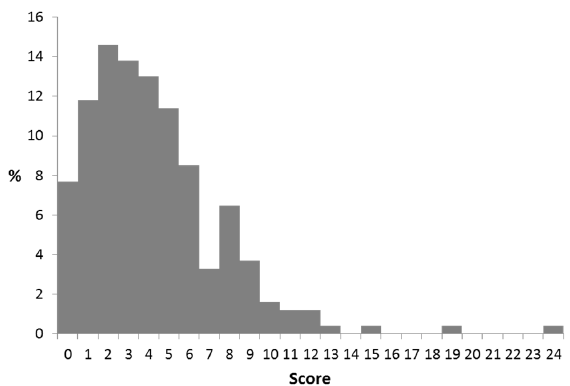
Figure 3. CoMiSS after intervention at final visit.